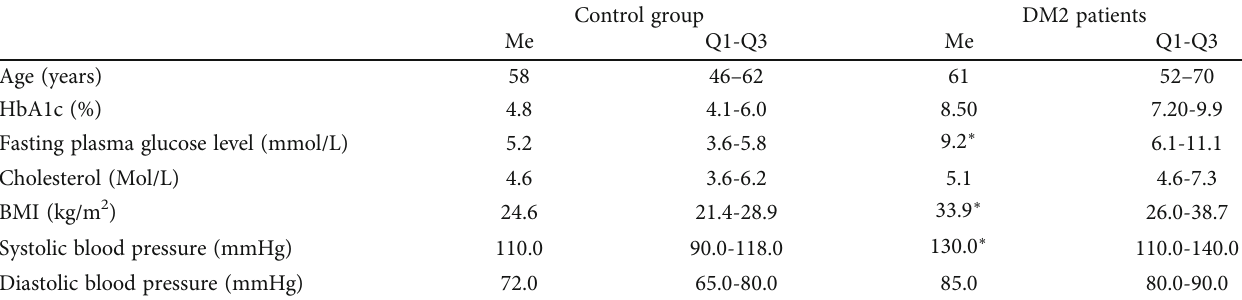
Table 1: Characteristics of the whole study